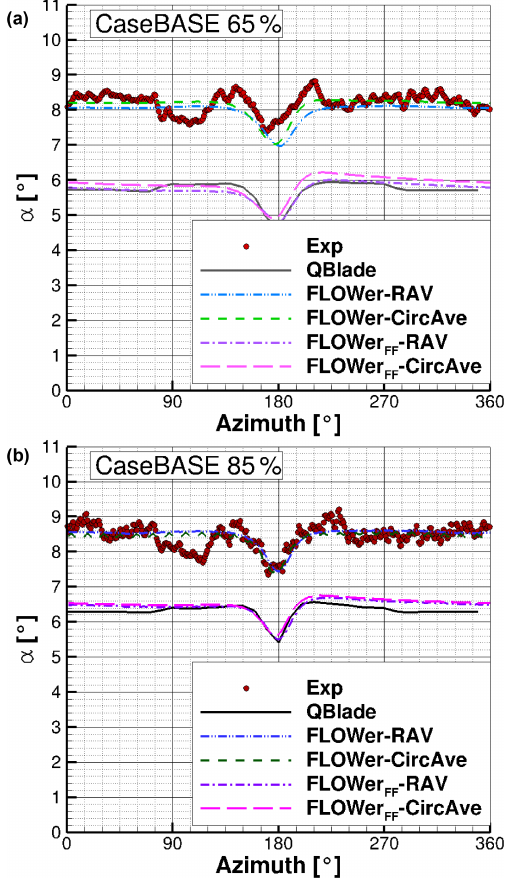
Figure 15. AoA distribution over the azimuth for CaseBASE for the experiment, QBlade and FLOWer (RAV and CircAve for wind tunnel and far field each) at 65% R (a) and 85% R (b) .